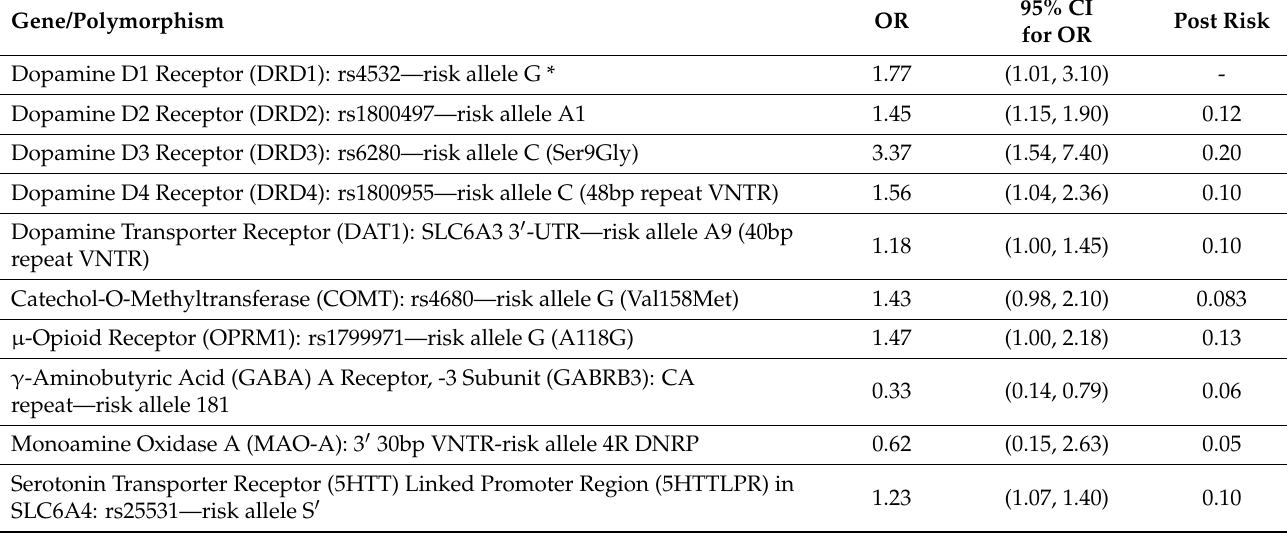
Table 2. Odds ratios and likelihood ratios of polymorphisms under